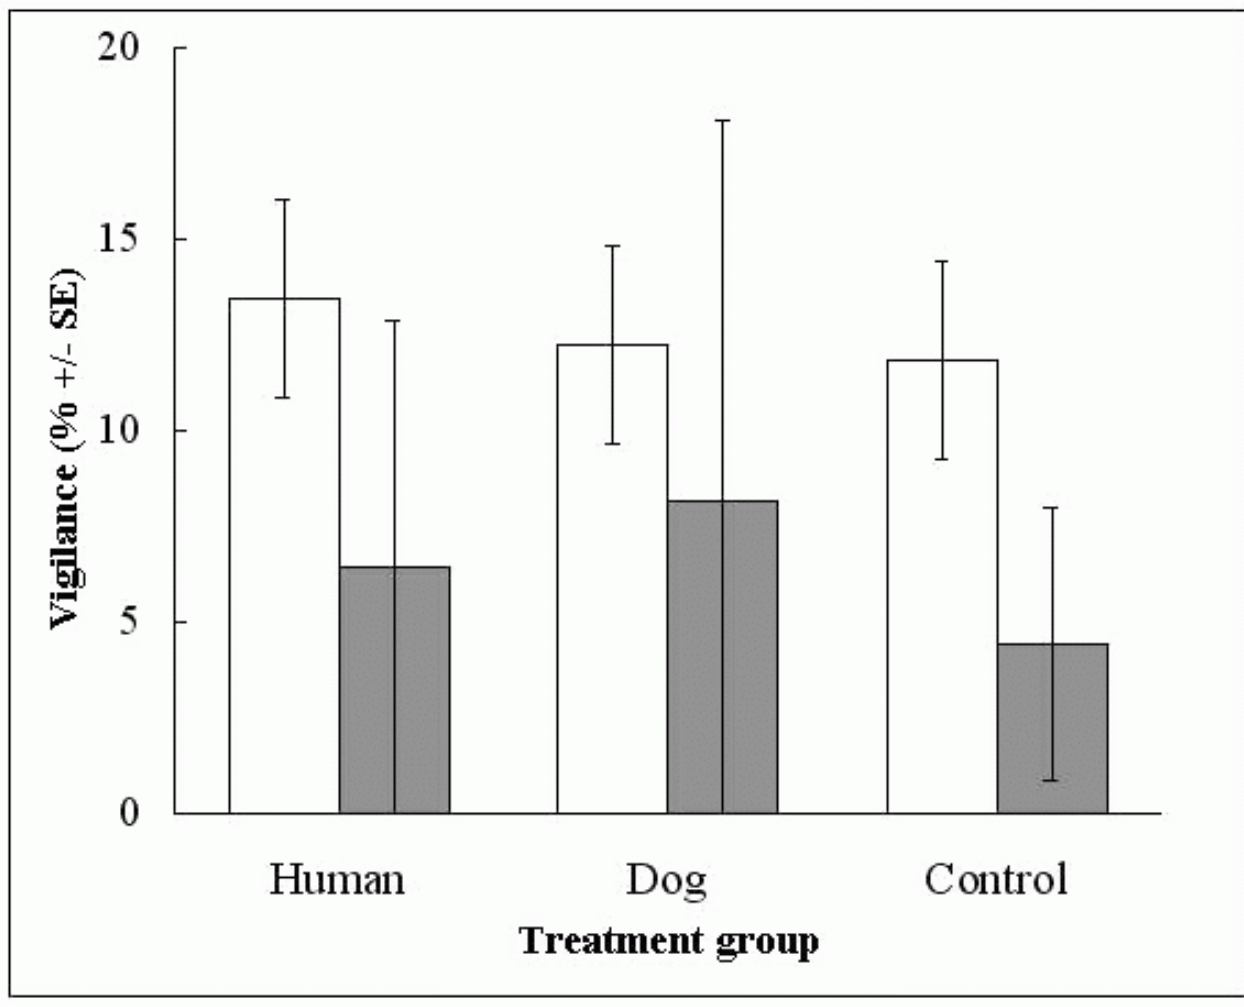
Fig. 4. Proportion of time elk spent vigilant (% ± SE), before (white column) and after (gray column) aversive conditioning treatments were applied to the three treatment groups in Banff National